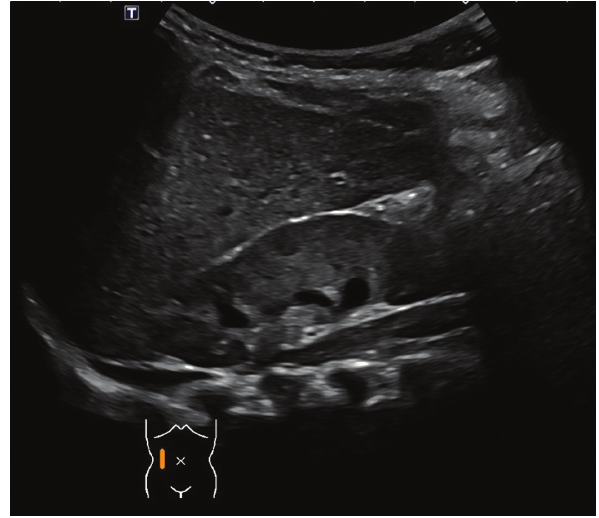
Fig. 4 Ultrasound examination of right kidney at 1 year.